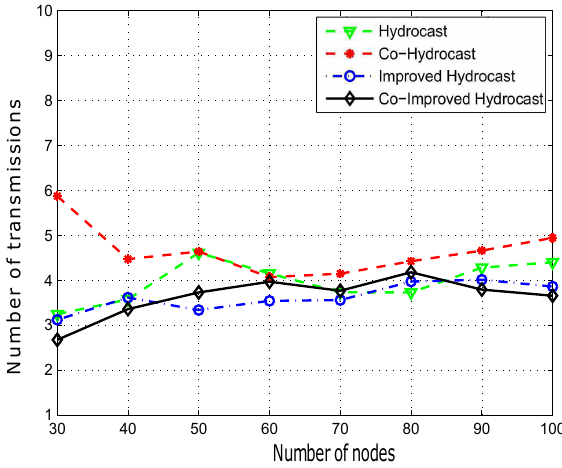
Figure 14. Number of transmissions for packet delivery.